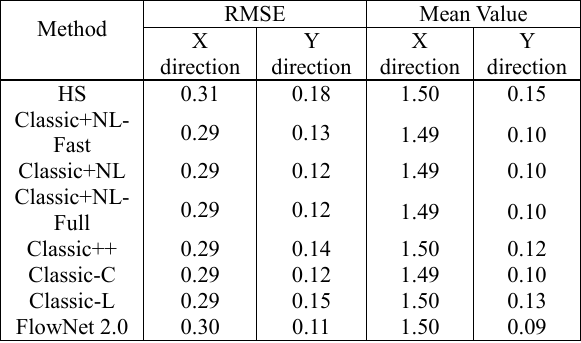
Table 1. The comparison of RMSE and Mean Value for different optical flow estimation methods (unit is pixel)